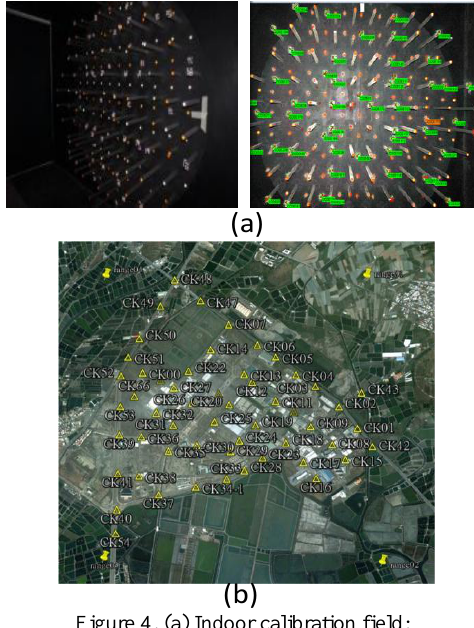
Figure 4. (a) Indoor calibration field; (b) Distribution of GCPs in test field